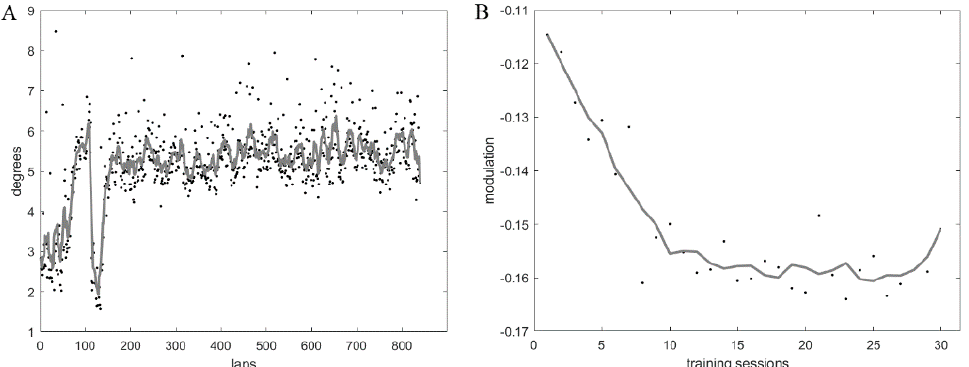
Figure 2. Performance in the training task from a single participant (S03). Black dots in (A) present the computed TE in each lap. (B) presents how modulation changed across training sessions in S03, considering the same lap (7th). Higher absolute values of modulation stay for higher resistance toques exerted. Grey lines represent the same data smoothed with a moving average window (width 1% of the total number of data points).